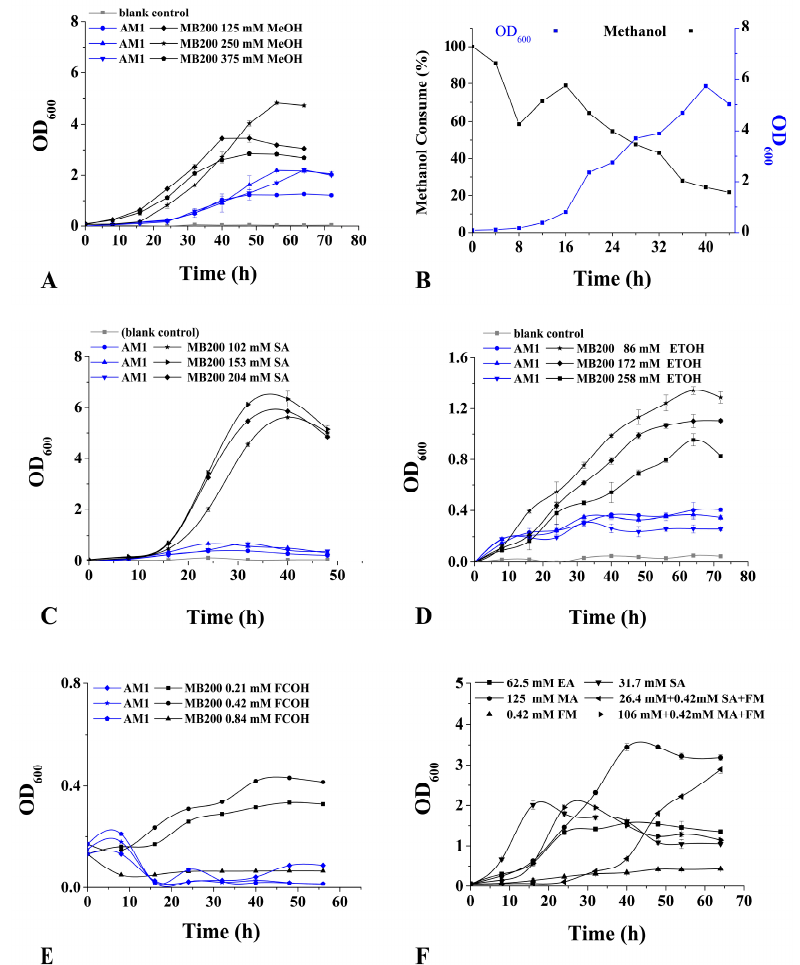
Figure 1. Growth profile of the strain MB200 and strain AM1. ( A ) The cells were grown on methanol (125, 250, and 375 mM) as the sole carbon and energy source. ( B ) Growth curves and methanol (250 mM) consumption curves in the strain MB200. ( C ) The cells were grown on succinate (102,